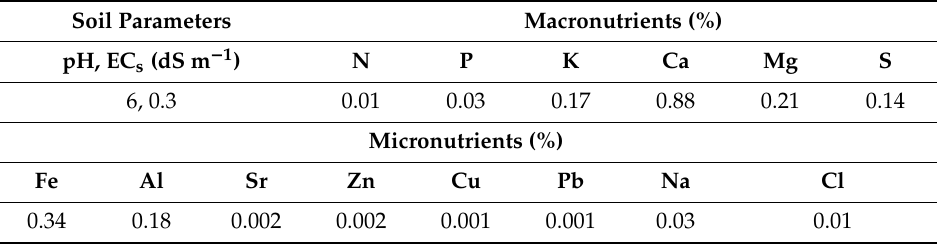
Table 1. Soil parameters and mineral elements (macro- and micronutrients). Soil